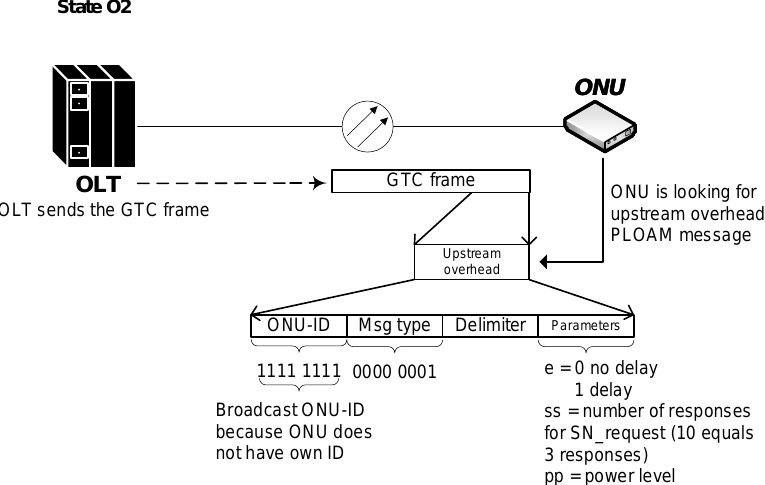
Figure 8. Activation process of ONU in a GPON network with PLOAM message details for state